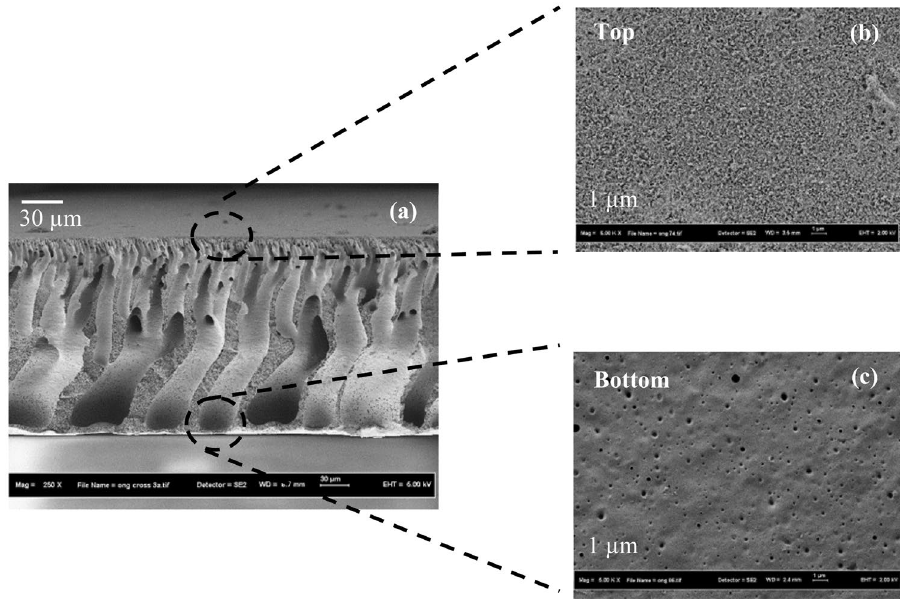
Figure 6. FESEM images of double-skinned TFC membrane, ( a ) cross-sectional morphology, ( b ) top PA selective and ( c ) PMAPS-grafted bottom